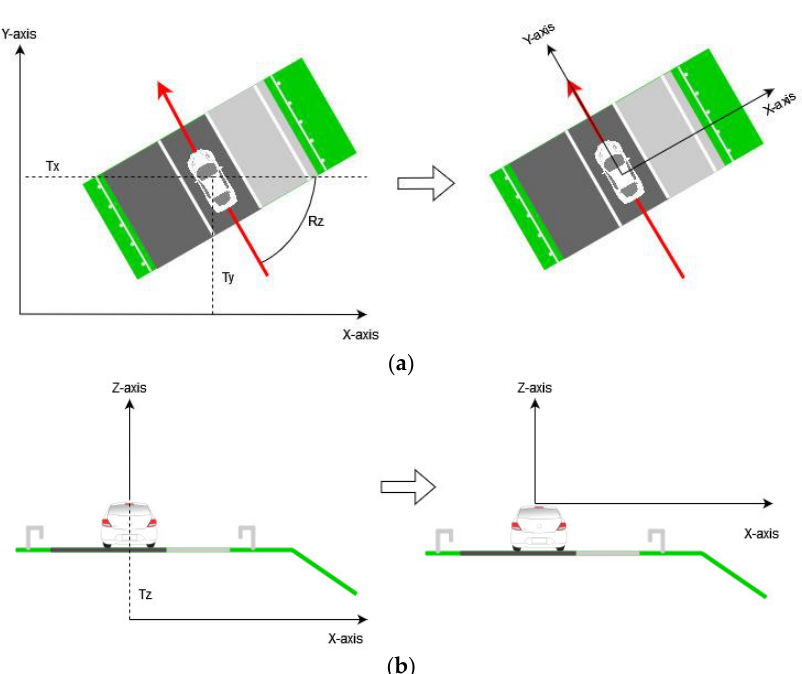
Figure 4. ( a ) Process of translation in direction of x-axis and y-axis and rotation around z-axis for Rz angle; ( b ) process of translation in direction of z-axis.